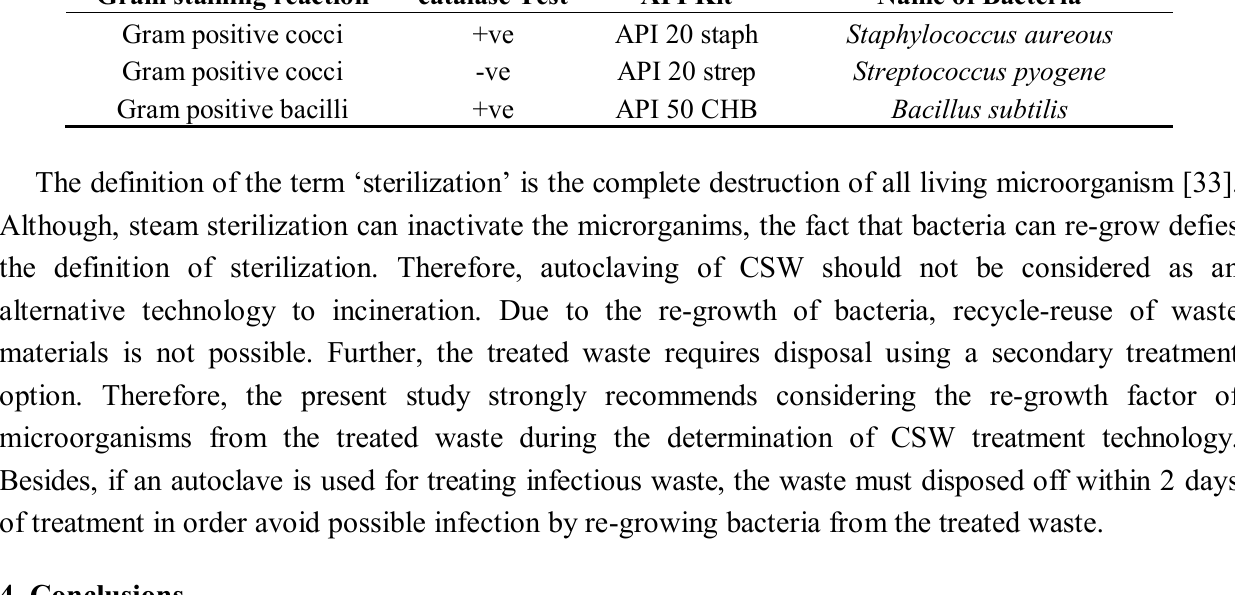
Table 5. Detection of Gram positive bacteria re-growing bacteria in sterilized waste. Gram staining